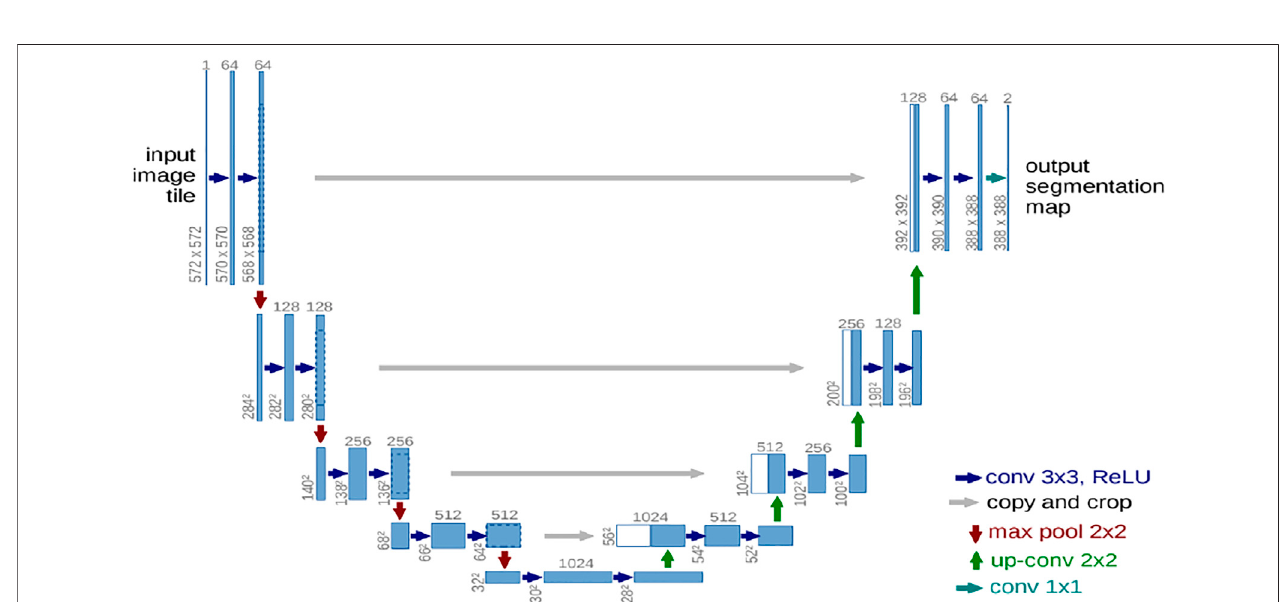
FIGURE 3 | U-Net architecture (Ronneberger et al.,